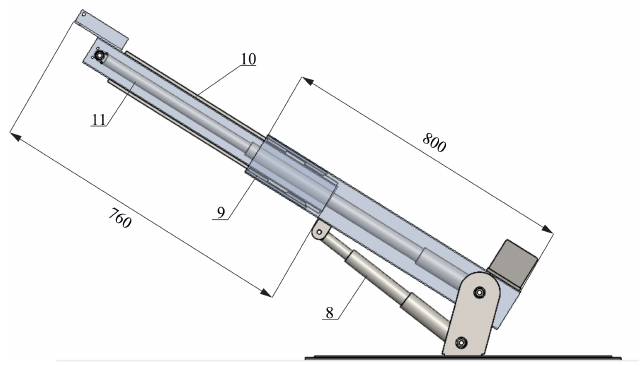
Figure 3. Schematic diagram of the designed laboratory crane (telescopic